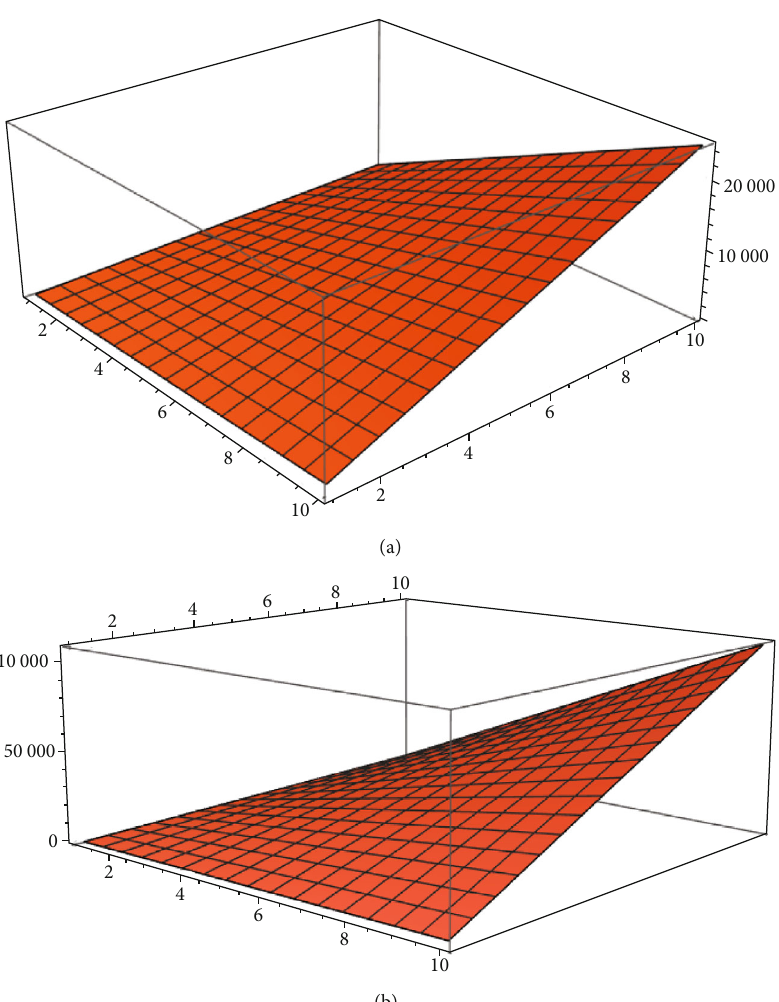
Figure 4: (a) First ve-deg M-beta index and (b) second ve-deg